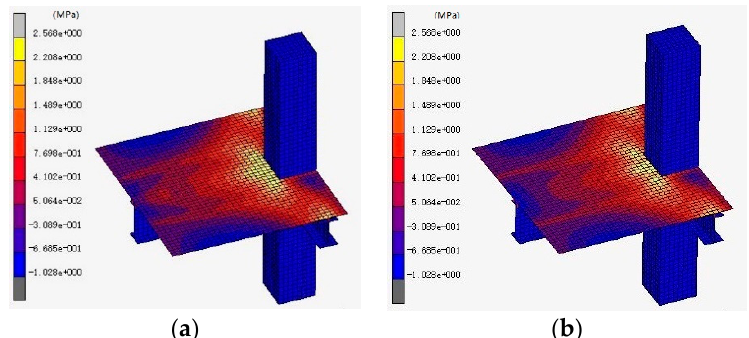
Figure 17. Concrete tensile stress distributions in the concrete slab subjected to vertical loads. ( a ) Concrete stress in the Stud model; ( b ) concrete stress in the URSP-0.5 L model .